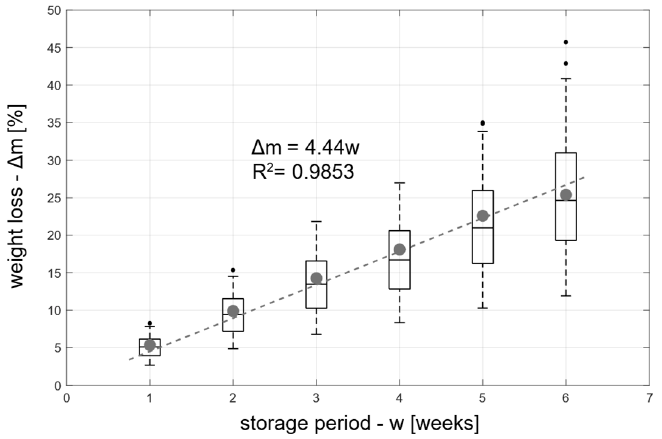
Figure 1. Effect of ambient temperature on the weight loss of Golden Delicious apples during stor-